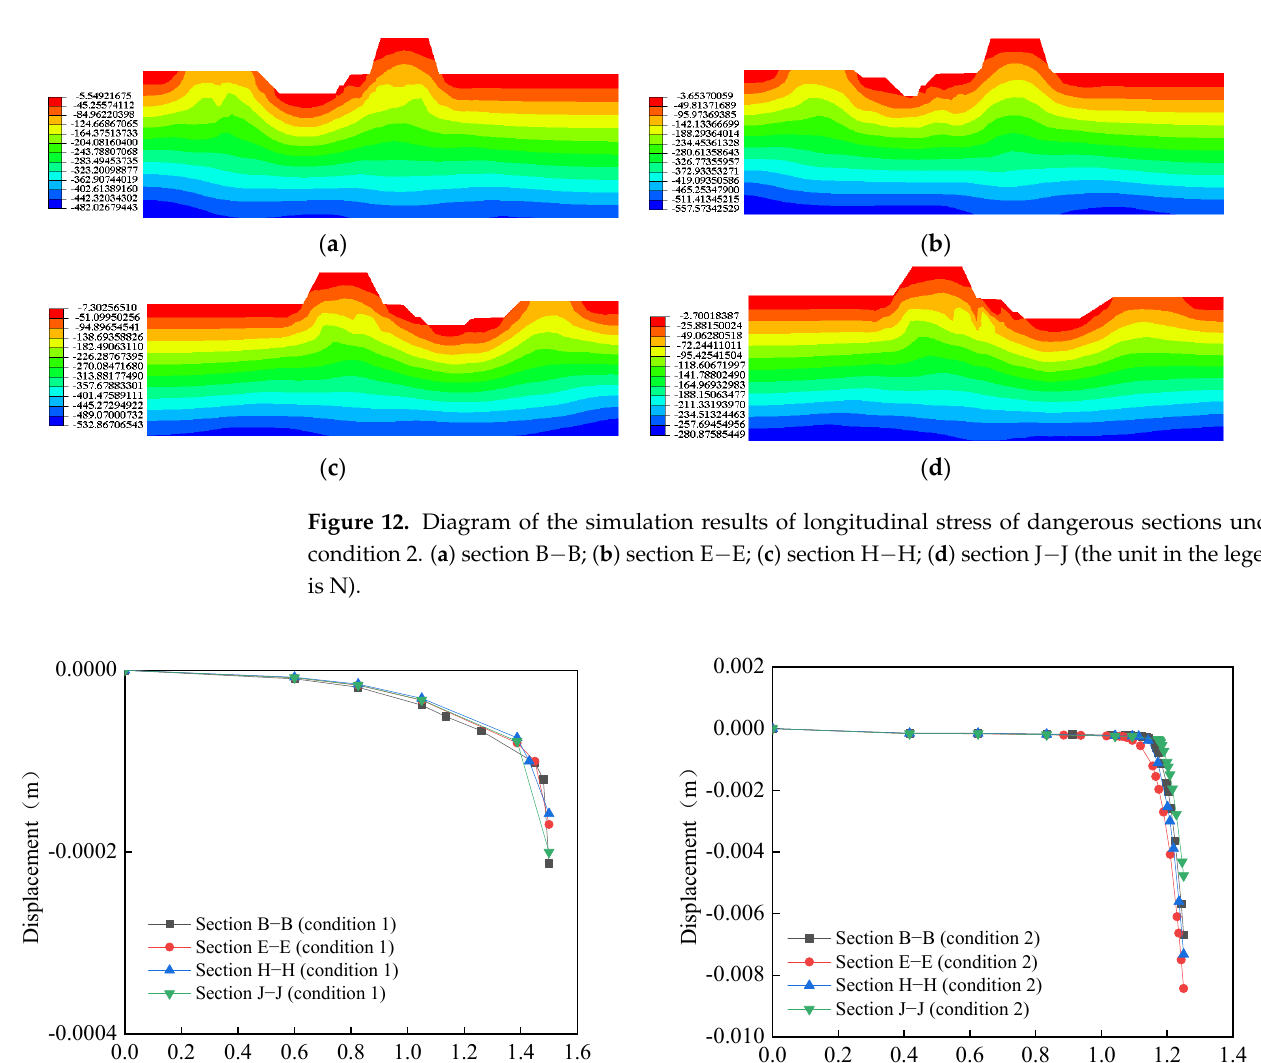
2. ( a ) Section B−B; ( b ) section E−E; ( c ) section H−H; ( d ) section J−J (the units in the legend are meters).